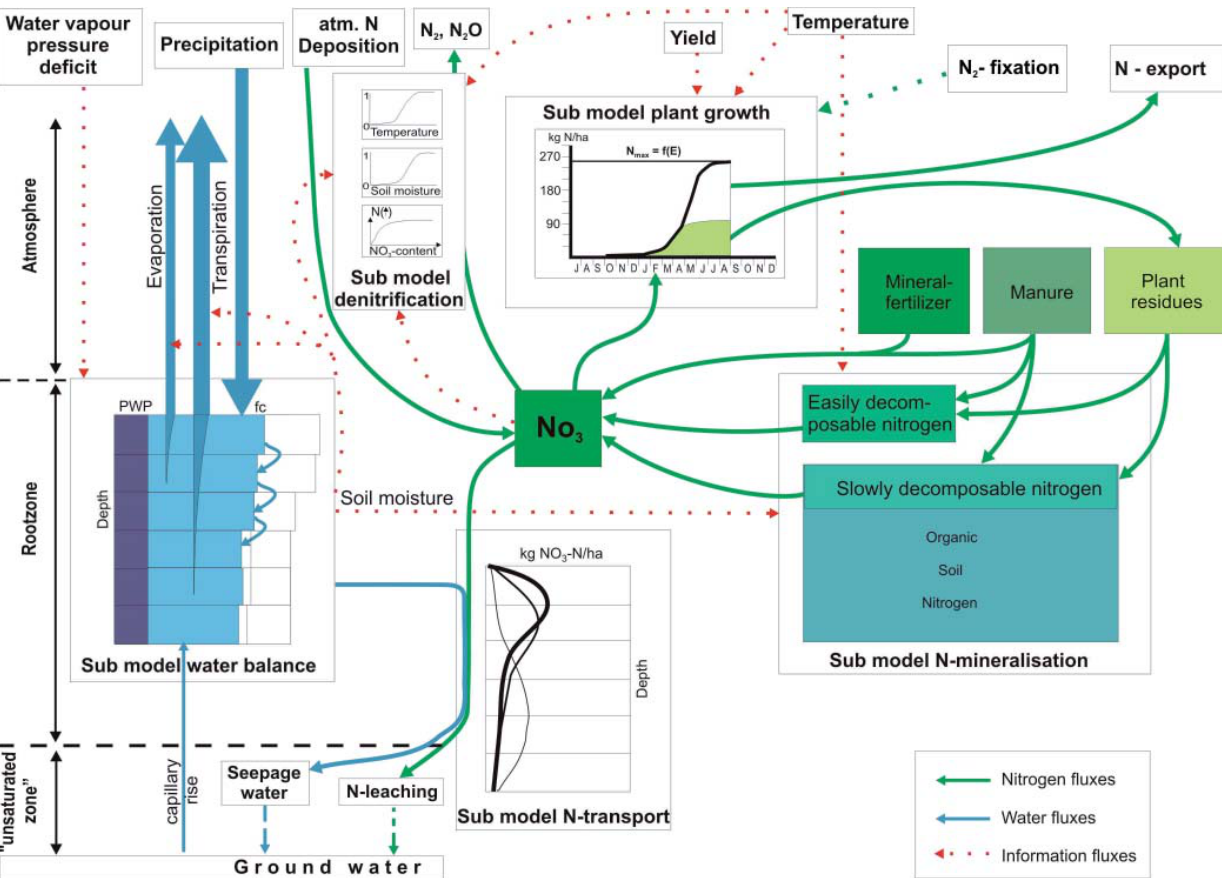
Figure 4. Sketch of the HERMES and SULFONIE